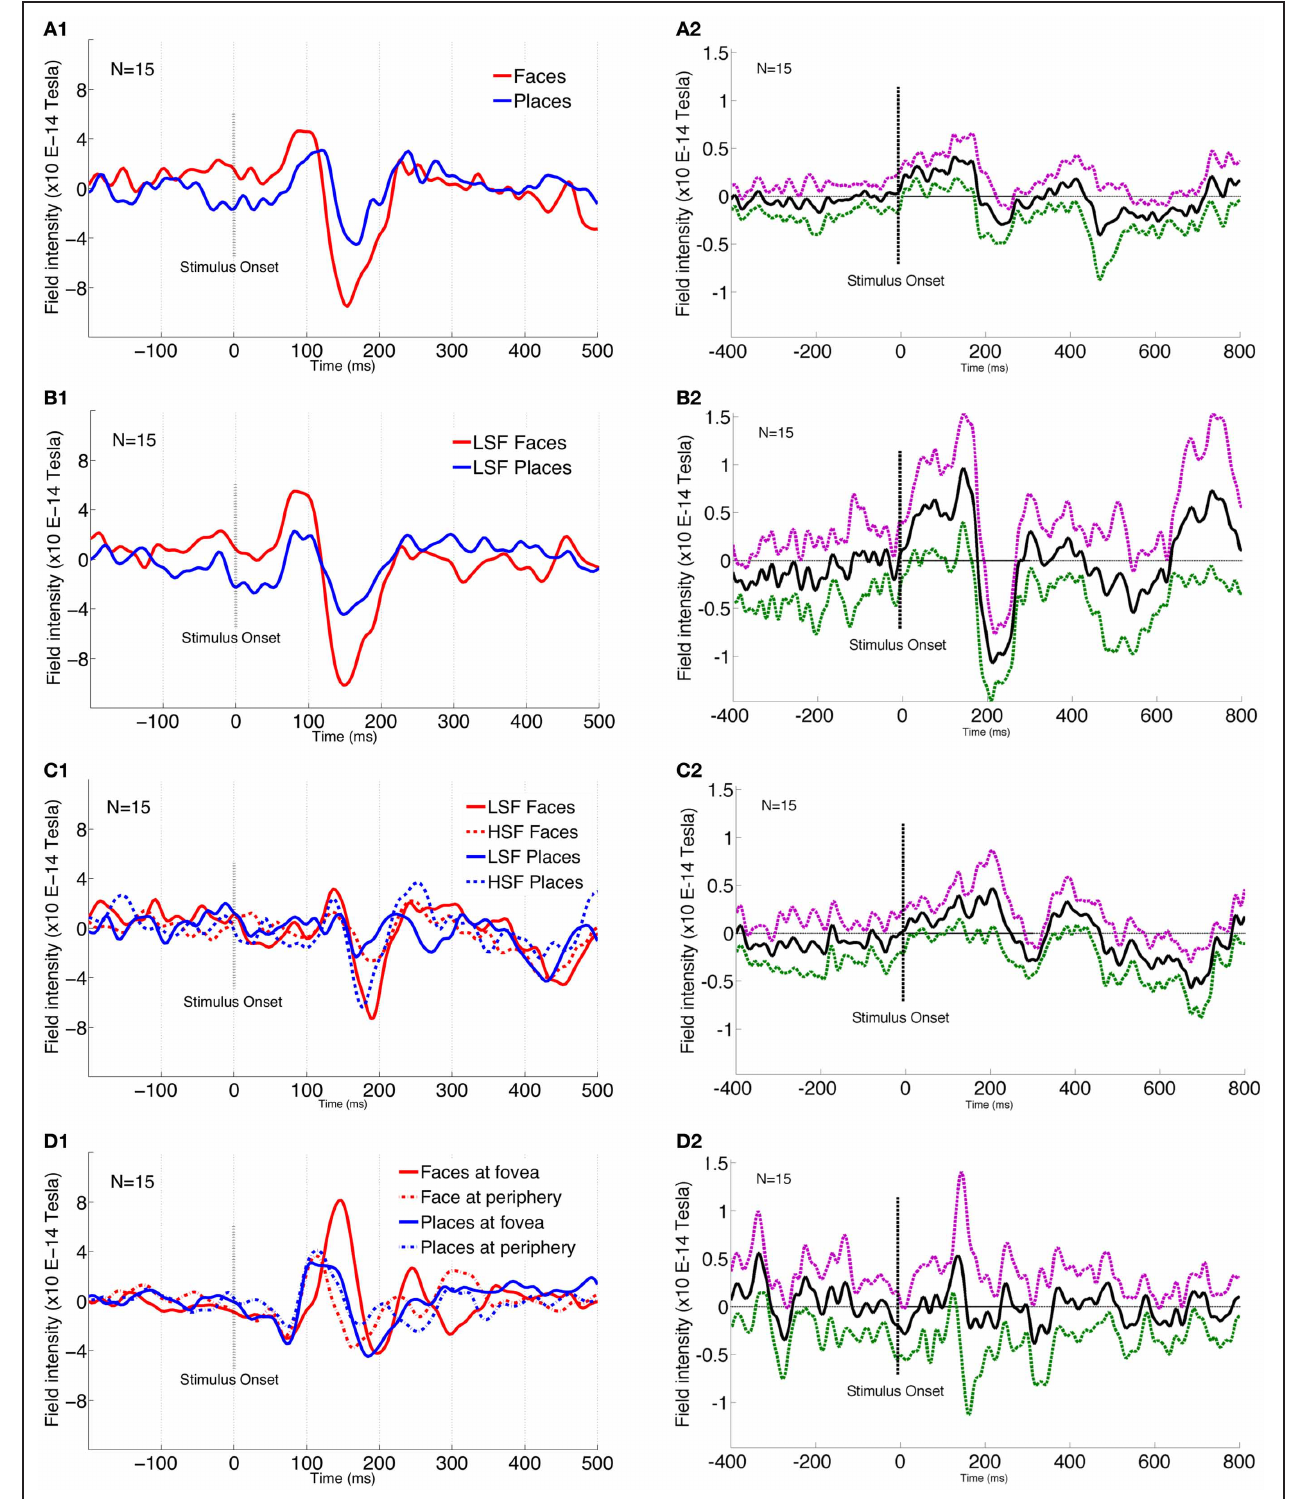
FIGURE 3 | MEG 170 amplitude plots for various conditions. 1 plots show the individual conditions where the images are cropped to show between − 200 and 500ms around the stimulus onset. 2 plots show the difference of conditions compared across the entire window of − 400 and 800ms around